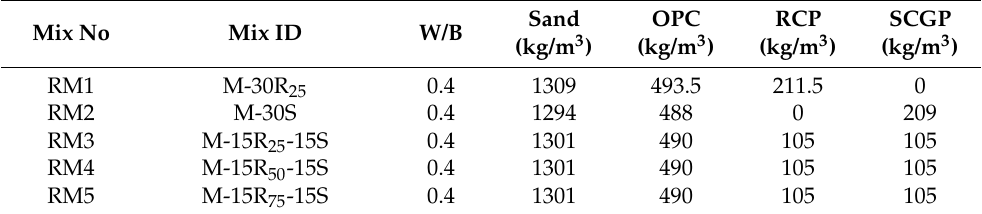
Table 3. Mix proportions of eco-efficient